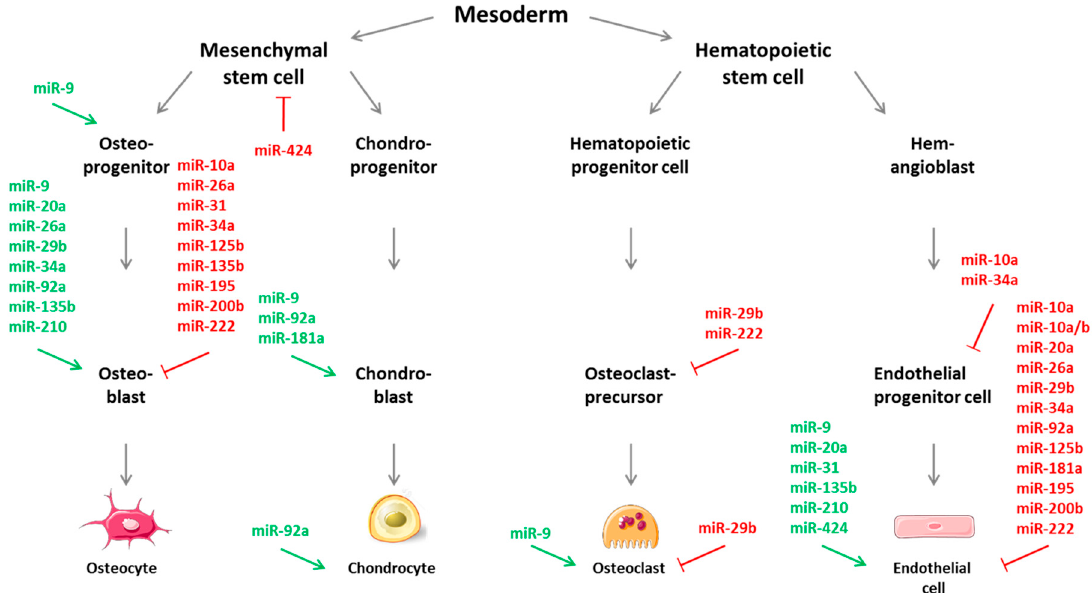
Figure 2. Regulating effects of microRNAs (miRs/miRNAs) involved in the regulation and coupling of bone angiogenesis (“CouplingmiRs”) during cell fate determination. MiRNAs were assigned with their individual positive/stimulatory (green colored) or negative/inhibitory (red colored) function and occurrence during the specific differentiation steps of osteogenic and angiogenic cells. Cell images